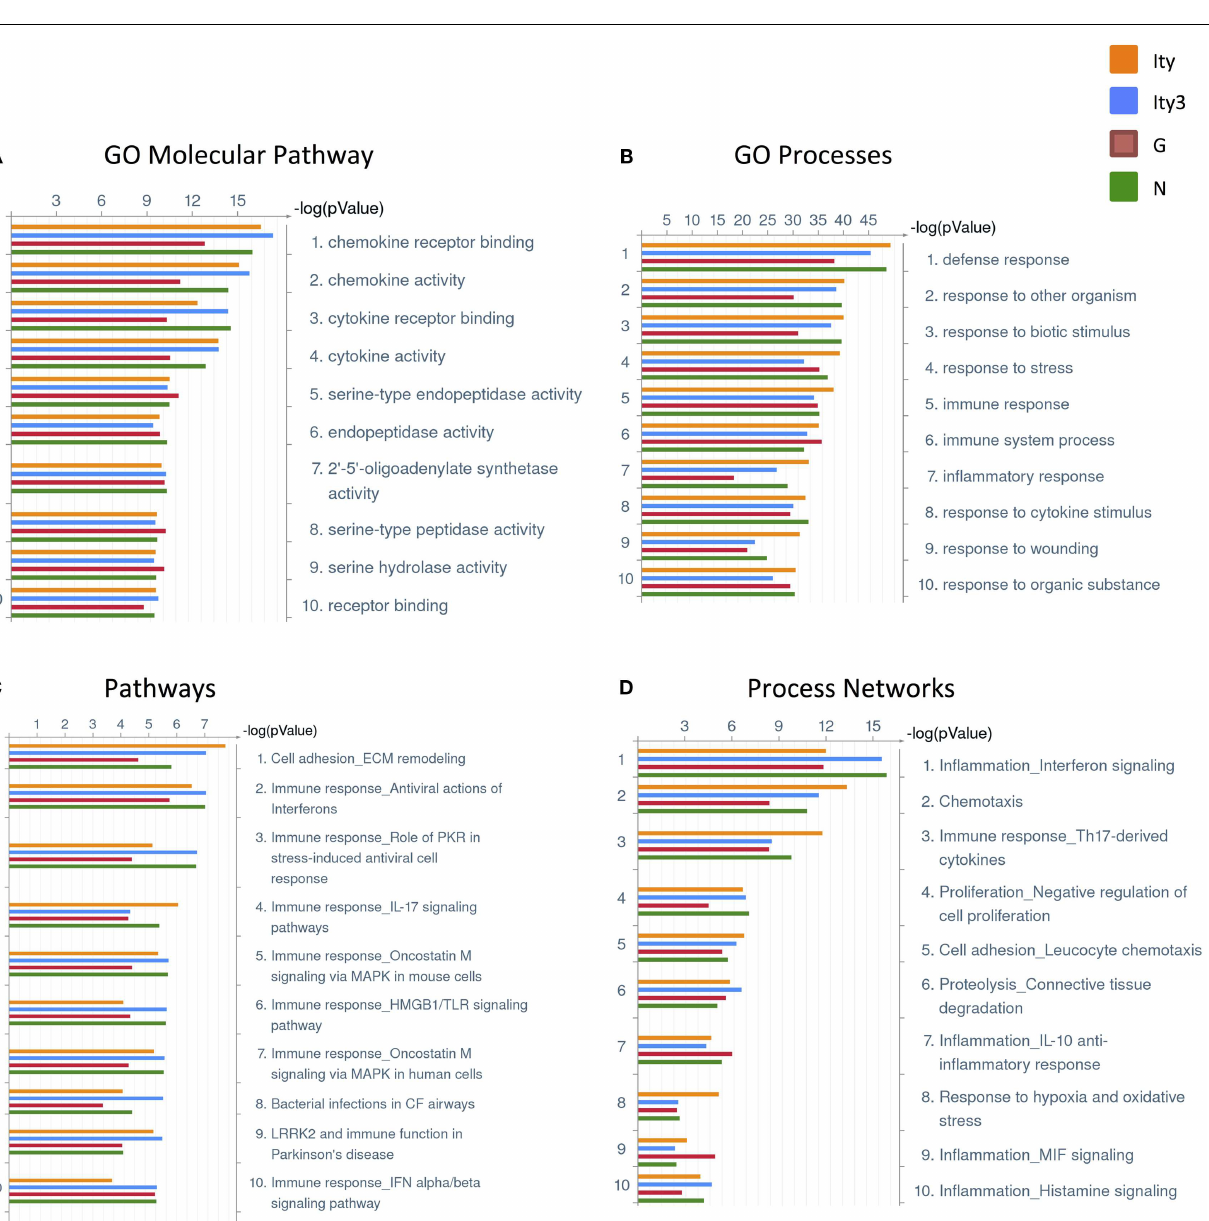
FIGURE 2 | Pathway and process analyses of genes differentially regulated in the spleen of Ity , Ity3 , Ity3.RecG , and Ity3.RecN mice during infection . Gene ontology classifications generated by clustering the genes that are differentially regulated in each strain upon infection. (A) Gene ontology (GO) molecular pathways and (B) Gene ontology (GO) processes (C) pathways (D) Process networks that are enriched in the four mouse